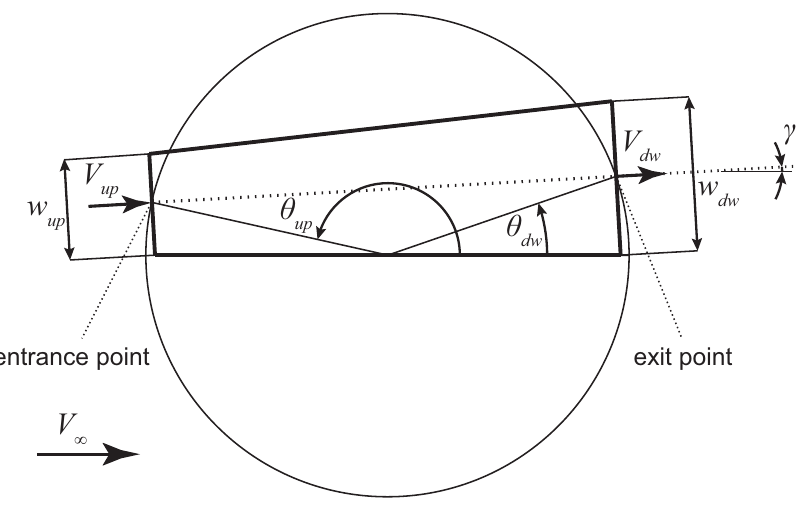
Figure 4. Cross-section of a